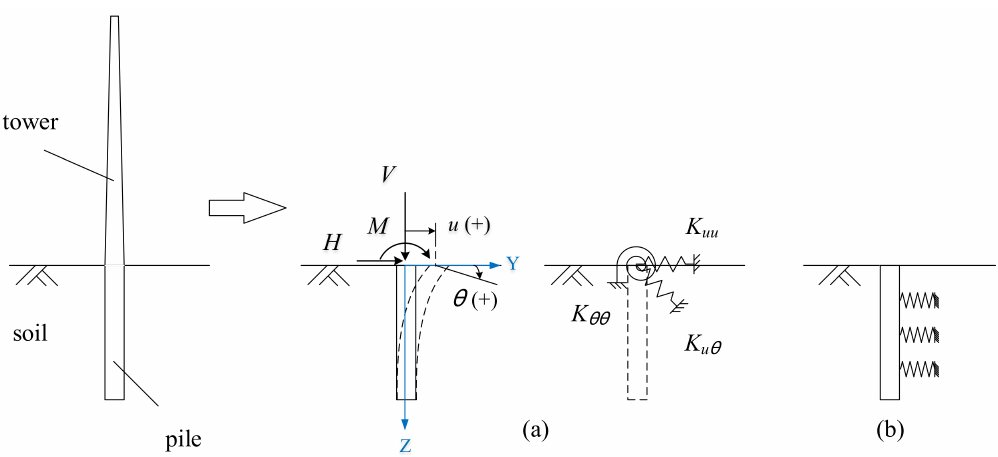
Figure 8. Simulation types of foundation of offshore structure. ( a ) Coupled-springs foundation model; ( b ) Distributed-springs foundation